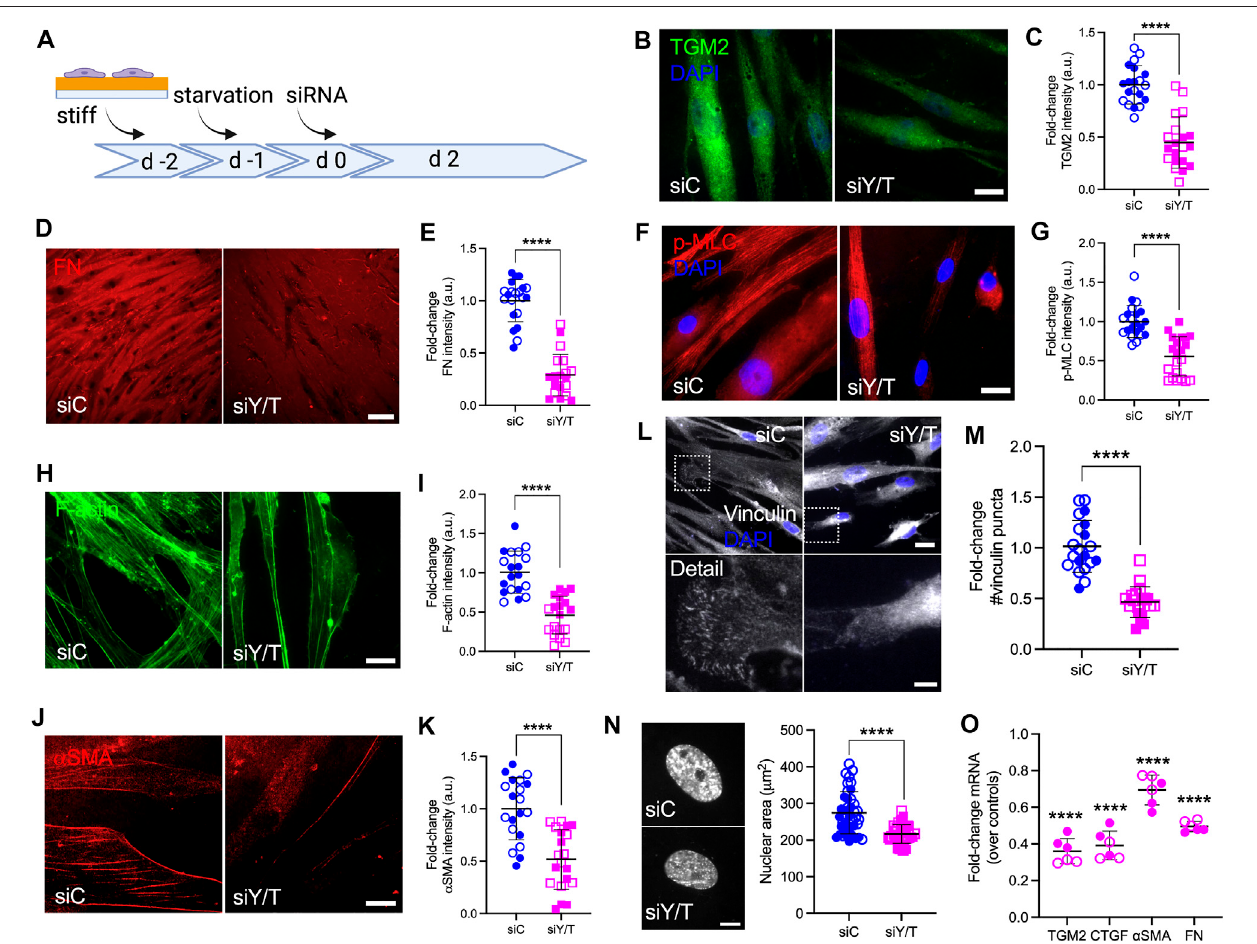
FIGURE5| YAP/TAZareregulatorsofFA formation, ECMremodeling and cellcontractilepropertiesinHTMcells. (A) Schematicshowingtime course ofYAP/TAZ depletion using siRNA experiments with HTM cells. (B,D,F,H,J and L) Representative fl uorescence micrographs of TGM2, FN, α SMA, F-actin, p-MLC and vinculin in HTMcellsonstiffhydrogelssubjectedtosiControlorsiYAP/TAZ(dashedboxshowsregionofinterestinhighermagni fi cationimage; TGM2/F-actin=green;FN/p-MLC/ α SMA = red; vinculin = grey; DAPI = blue). Scale bar, 20 μ m in (B,F,H,J) ; 20 and 5 μ m in L; 100 μ m in D. (C,E,G,I,K,M) Analysis of TGM2, FN, α SMA, F-actin, p-MLCand number ofvinculin puncta ( n = 20images from 2HTM cell strains withthree replicates per cell strain). (N) Representative fl uorescence micrographs and size analysis ofHTM cell nuclei on stiff hydrogels subjected to siControl or siYAP/TAZ ( n = 40 images from 2 HTM cell strains with six replicates per cell strain; more than 100 nucleiwereanalyzedpercellstrain). (O) mRNAfold-changeofFN,TGM2,CTGF, α SMAinHTMcellsonstiffhydrogelssubjectedtosiControlorsiYAP/TAZbyqRT-PCR. The mRNA levels were normalized to the levels of GAPDH mRNA 48 h post transfection ( n = 6 replicates from 2 HTM cell strain). Open and closed symbols represent different cell strains. The lines and error bars indicate Mean ± SD; Signi fi cance was determined by unpaired t-test (C,E,G,I,K,M,N) and two-way ANOVA (O) using multiple comparisons tests (** p < 0.01; **** p < 0.0001).